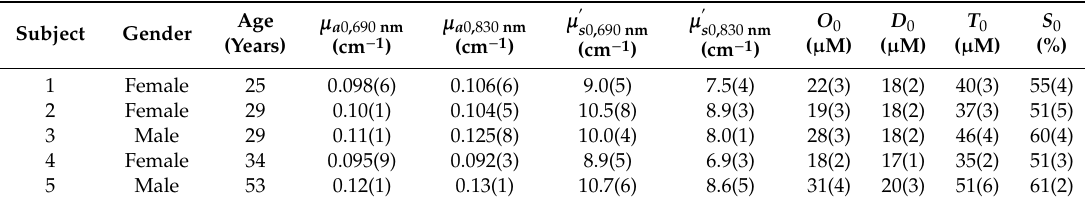
Table 1. Average baseline absorption coe ffi cients ( µ a ) and reduced scattering coe ffi cients ( µ (cid:48) s ) at 690 nm and 830 nm, oxy- ( O ), deoxy- ( D ), and total ( T ) hemoglobin concentrations, and hemoglobin saturation ( S ) for the five subjects. Numbers in parenthesis are the standard deviation on the last digit. The hemoglobin parameters are obtained assuming a 70% water volume